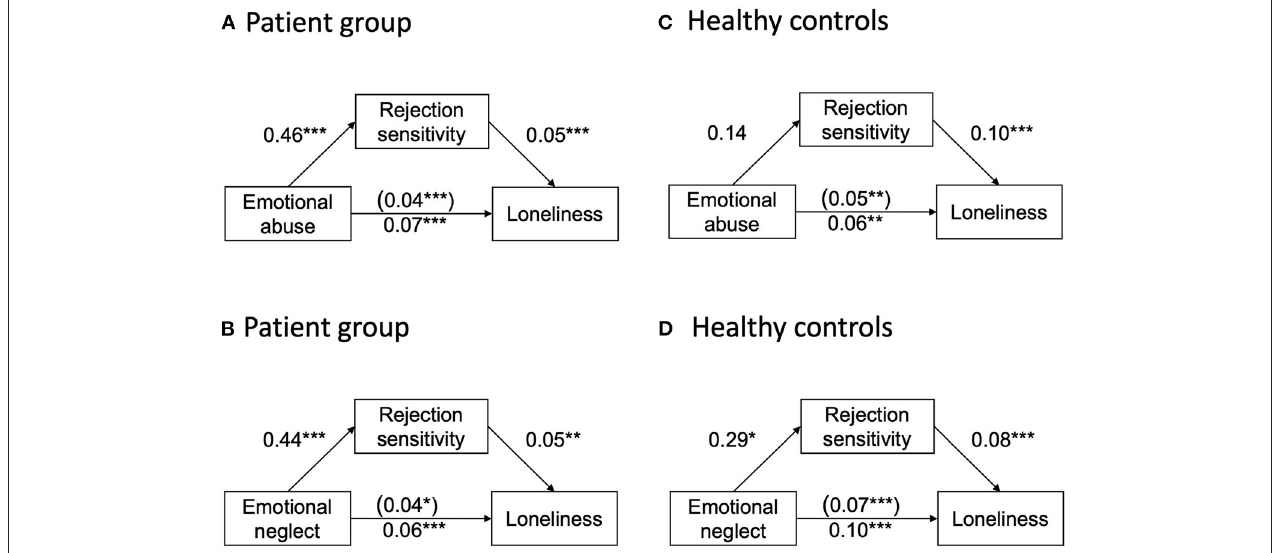
FIGURE 1 | (A) and (C) : Unstandardized regression coefficients for the relationship between emotional abuse and loneliness as mediated by rejection sensitivity for the patient (A) and healthy control sample (C) . The regression coefficient between emotional abuse and loneliness, controlling for rejection sensitivity, is in parentheses; (B) and (D) : Unstandardized regression coefficients for the relationship between emotional neglect and loneliness as mediated by rejection sensitivity for the patient (B) and healthy control sample (D) . The regression coefficient between emotional neglect and loneliness, controlling for rejection sensitivity, is in parentheses, * p < 0.05, ** p < 0.01, *** p <